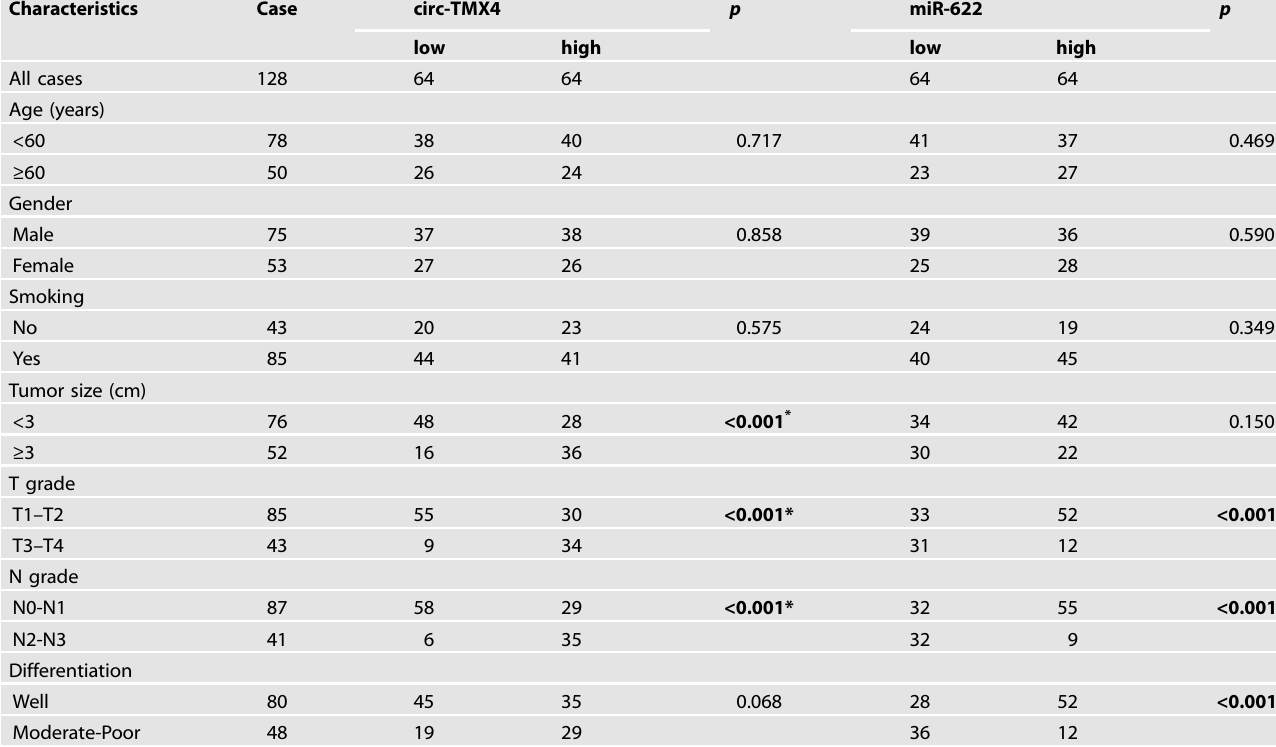
Table 1. Correlation between circ-TMX4/miR-622 expression and clinical pathologic characteristics.